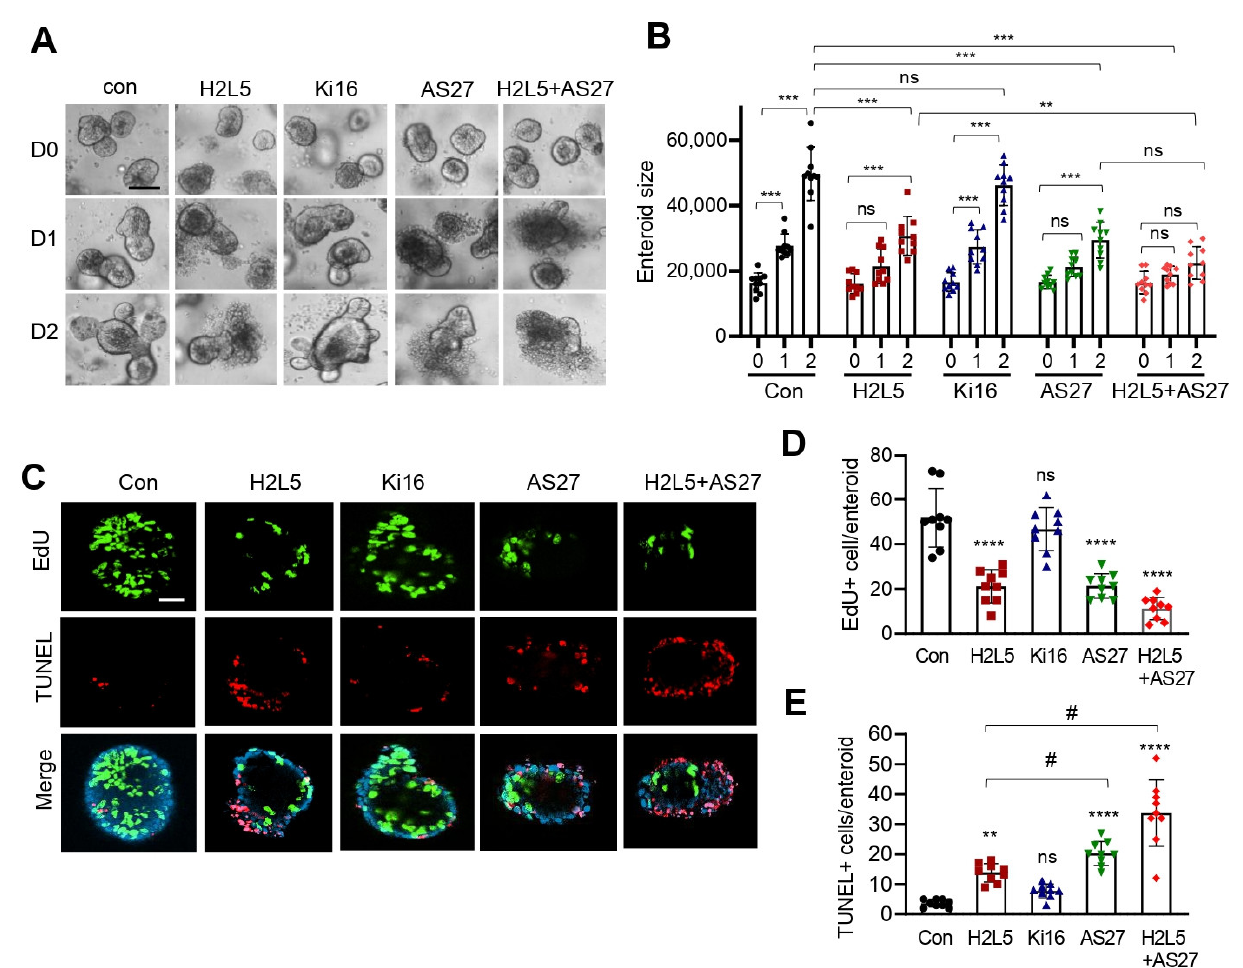
Figure 4. The growth of WT enteroids is suppressed by inhibition of LPA 2 and LPA 5 . ( A ) Representative images of Lpar5 f/f enteroids treated with LPA 2 inhibitor H2L5186303 (H2L5), LPA 1 /LPA 3 inhibitor Ki16425 (Ki16), LPA 5 inhibitor AS2717638 (AS27), or H2L5+AS27 are shown. Data are representative of 3 experiments. Scale bar = 50 μm. ( B ) The growth of Lpar5 f/f enteroids was quantified by determining the area of enteroids using ImageJ. All data are presented as mean ± SD. n = 10. *** p < 0.001, **** p < 0.0001, ns = not significant by two-way ANOVA with Tukey’s multiple comparison test. ( C ) Representative images of EdU and TUNEL staining in Lpar5 f/f enteroids treated with inhibitors are shown. Representative of three independent experiments. Bar = 50 μm. Quantification of EdU+ ( D ) and TUNEL+ ( E ) enteroid. n = 10. ** p < 0.01, **** p < 0.0001, ns = not significant compared to Con. # p < 0.0001.